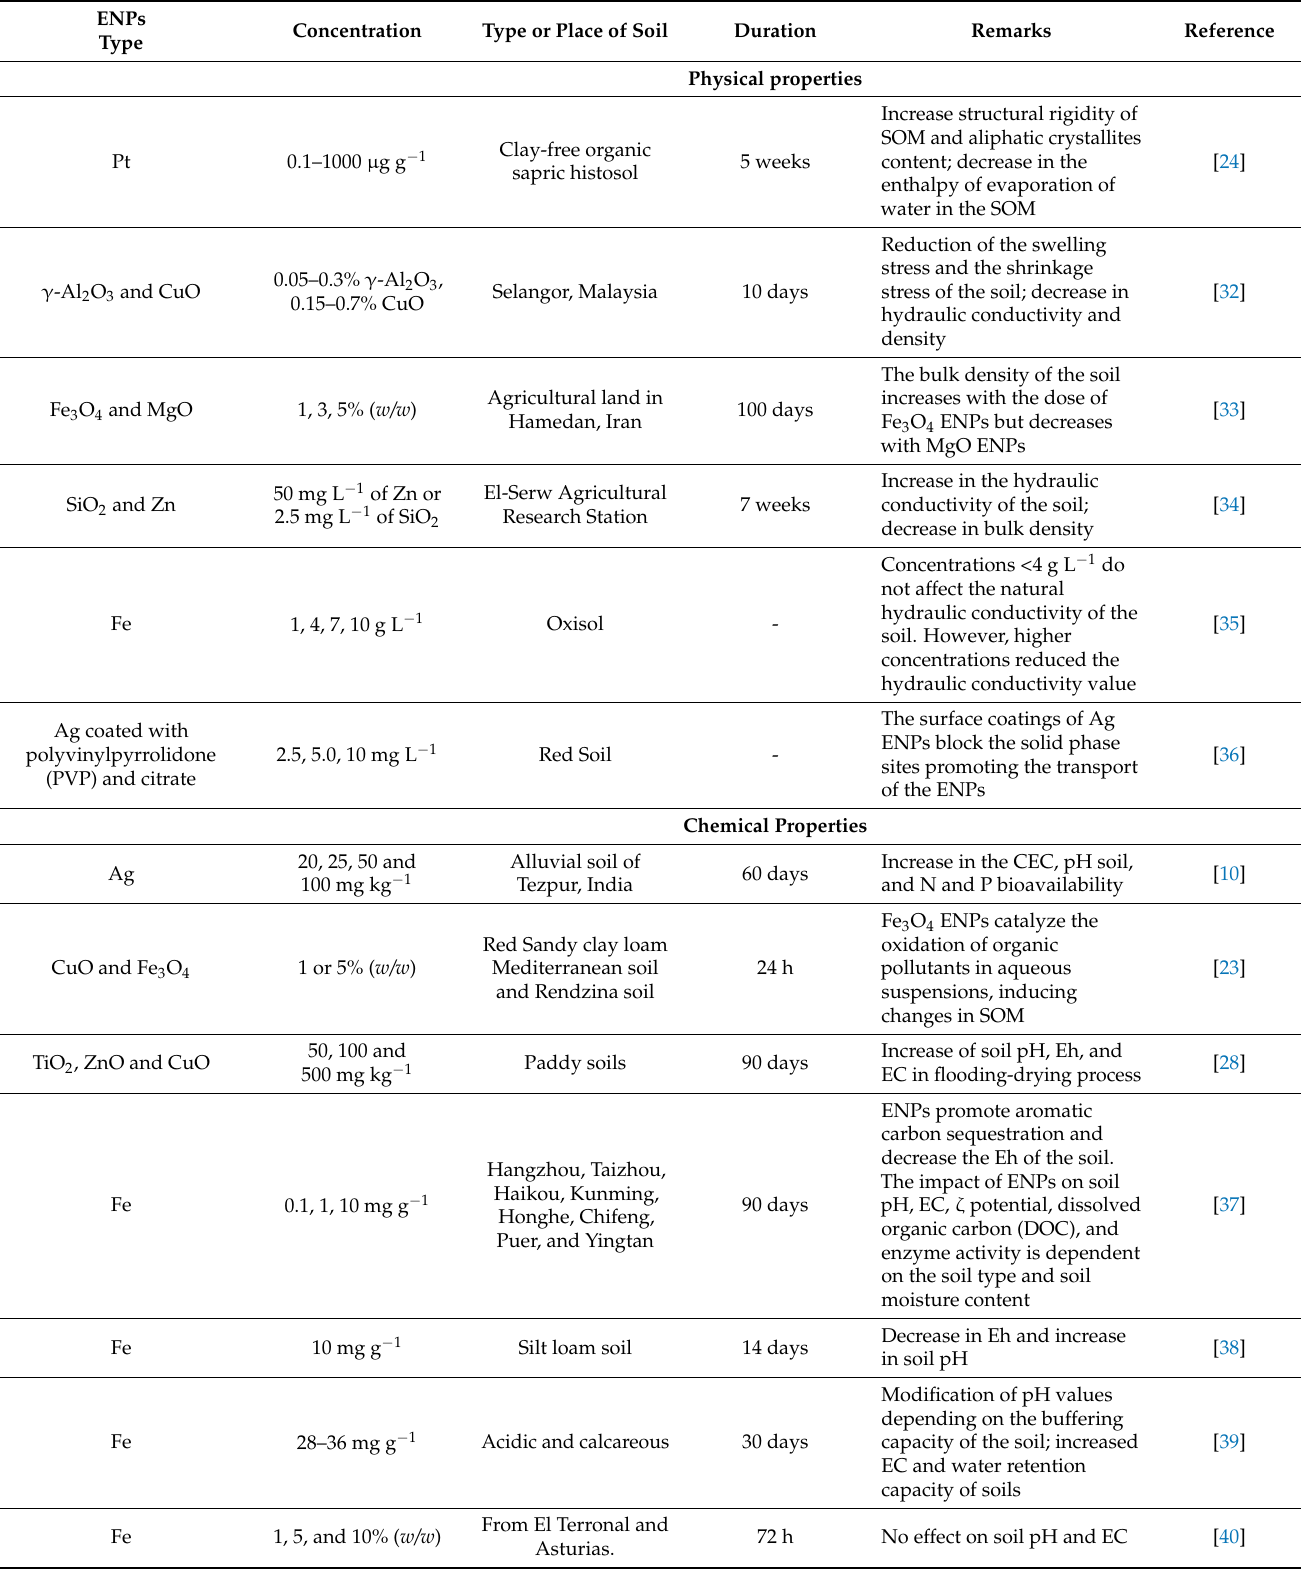
Table 1. Effect of metal and metallic oxide engineered nanoparticles (ENPs) on some soil physical and chemical